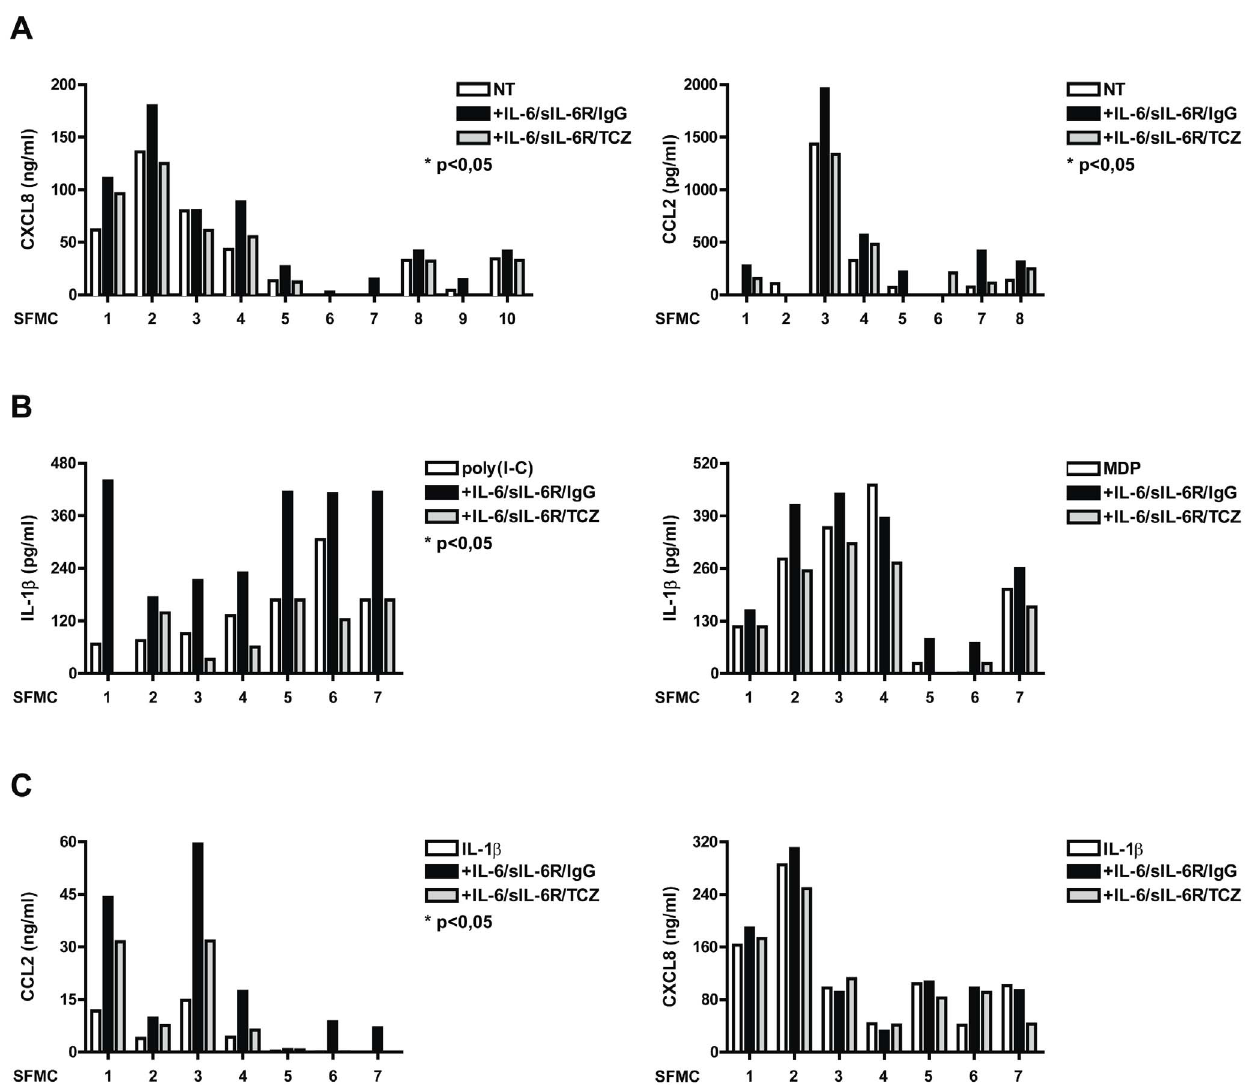
Figure 5. Exposure to IL-6 enhances cytokine and chemokine production in SFMC. SFMC were left to adhere on plastic for 3 hours in DMEM supplemented with 10% fetal calf serum (FCS). SFMC were pre-exposed to IL-6/sIL-6R in combination with IgG1 or with TCZ (50 m g/ml) for 1 hour. Cells were then left untreated ( A ) or stimulated with poly(I-C) and MDP ( B ), IL-1 b (1ng/ml) ( C ). CXCL8, CCL2 and IL-1 b levels were measured by ELISA. *p , 0.05 for values from IL-6/sIL-6R-stimulated compared with NT